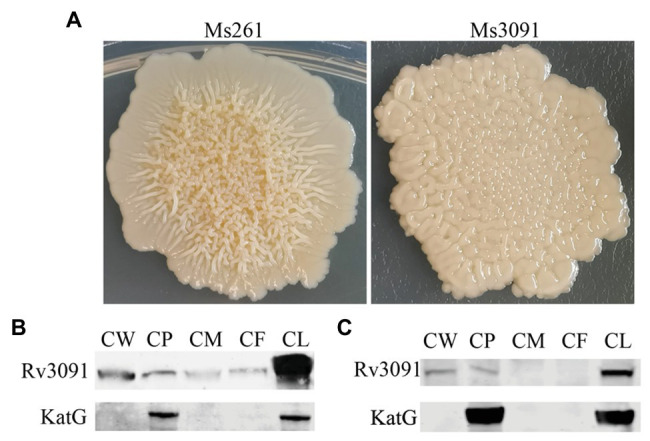
Subcellular localization of Rv3091 and its effects on colonymorphology of rMs. (A) Observation of single colony of Ms261 and Ms3091by magnification. (B) Subcellular localization of Rv3091 in Ms3091 using western blotting. (C) Subcellular localization of Rv3091 in Mycobacterium bovis BCG using western blotting. Culture filtrate (CF), whole-cell lysate products (CL), cell membrane (CM), cell wall (CW), cytoplasm (CP).